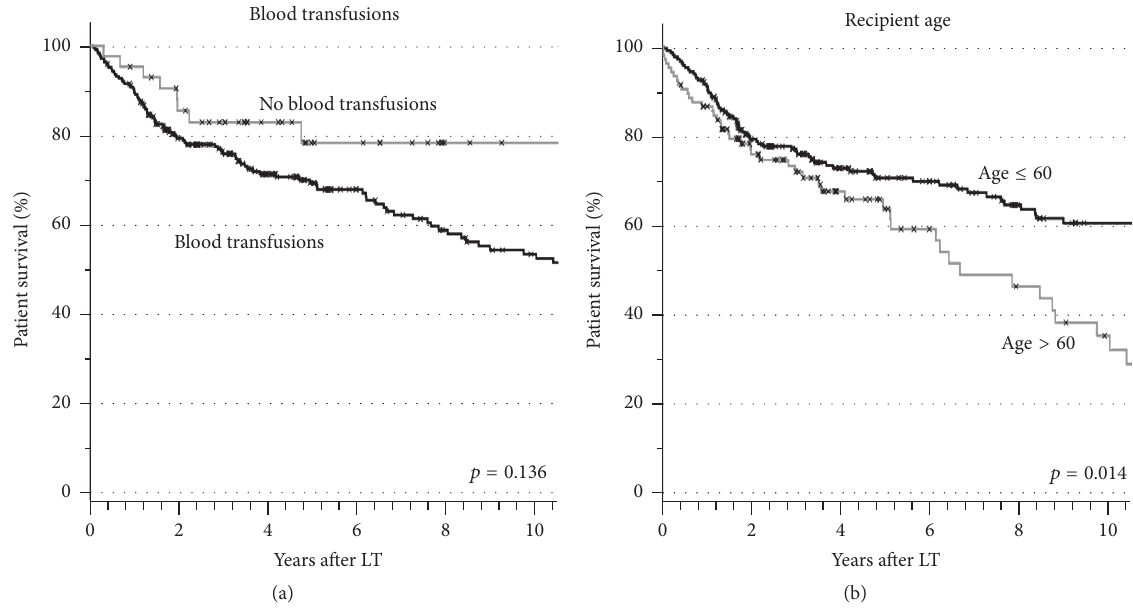
Figure 5: Actuarial patient survival in correlation with the application of blood transfusions (a) and with recipient’s age (b).